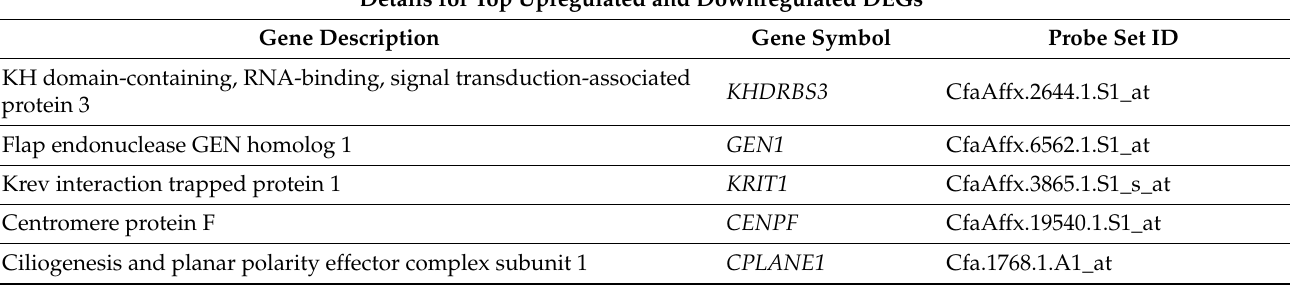
Figure 2. A heat map representing the color-coded expression levels (log-ratio M values) of the top six upregulated and five downregulated DEGs in the LPS treated tumor enteroids vs. the control tumor enteroids (Contrast-1). The log-ratio M values represent the log(R/G) (log fold change) [44]. The detailed information on genes is presented in Table 4. Table 4. Gene Ontology (GO) analysis and details about the top six upregulated and five downregu- lated DEGs in the LPS treated tumor enteroids vs. the control tumor enteroids. Details for Top Upregulated and Downregulated